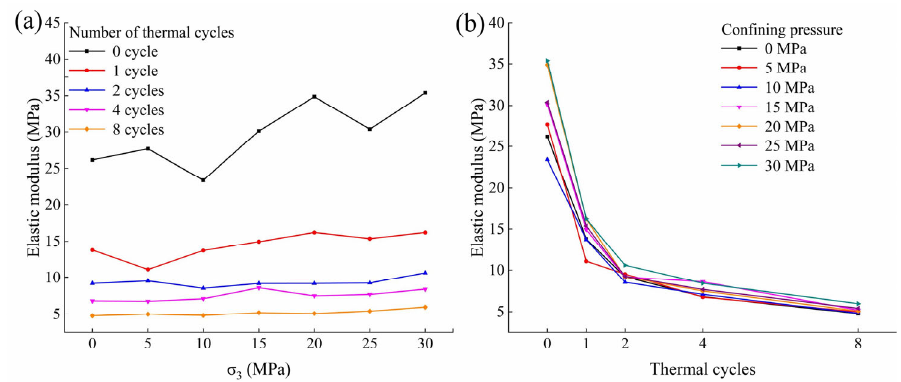
Figure 9. Relationship between elastic modulus of marble and the confining pressure and the number of thermal cycles. ( a ) Elastic modulus ‐σ 3 under different thermal cycles ; ( b ) Elastic modulus ‐ thermal cycles under different confining pressure.